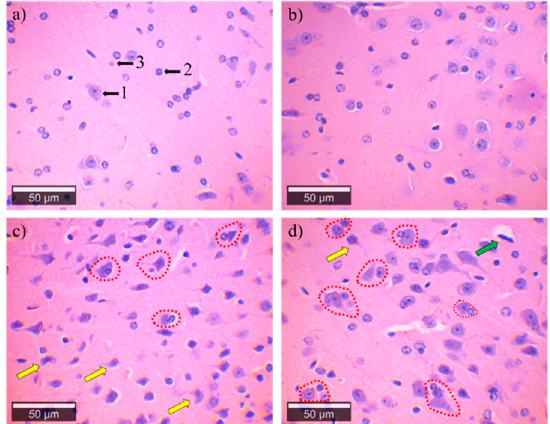
Figure 4. Microphotographs of the brain of the groups exposed to an increase of 50×, 3rd to 4th cortical zone. ( a ) Control group showing the normal structure in the brain cells; the black arrows represent (1) pyramidal neurons, (2) astrocyte and (3) oligodendrocyte. ( b ) Brain cells of the Cócorit group without apparent alterations. ( c , d ) Mice brains are exposed to water from Vícam and Pótam, respectively. These groups showed satellitosis (red), neuronal vacuolation (green arrow), and angular degeneration of neurons (yellow arrow).